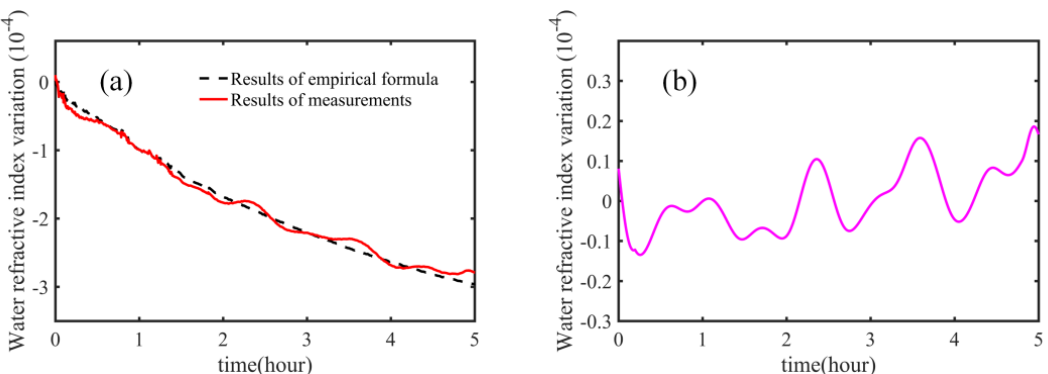
Figure 6. Long time measurements of the group refractive index of water. ( a ) Results obtained using the empirical formula and our measurements; red solid line: result of our method; black dashed line: result of the empirical formula; ( b ) difference between the results of empirical formula and our measurements.